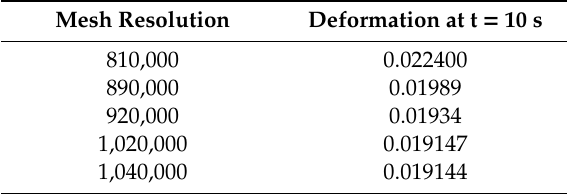
Figure 7. ( a ) Computational mesh of fluid domain, ( b ) enlarged view around beam surface, and ( c ) computational mesh of beam. Table 3. Mesh convergence study for the computational domain.